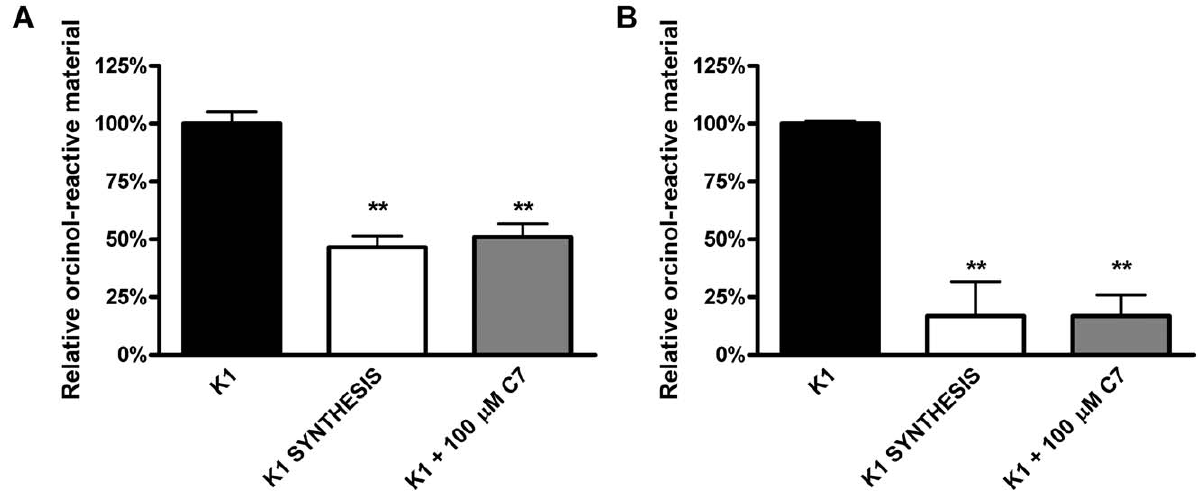
Figure 3. C7 treated cells produce less orcinol-reactive carbohydrates. Cells were ( A ) sonicated or ( B ) treated with mild acid to release cell surface polysaccharides. Material was then extracted and polysaccharides were detected using the orcinol reagent. C7 treated cells had levels of orcinol-reactive carbohydrates comparable to those of a capsule synthesis (K1 SYNTHESIS) mutant for both whole cell sonicates as well as released surface material. This suggests that capsule levels are reduced by C7 treatment, and the compound does not simply release capsule from the bacterial surface. Absorbance readings were expressed as the percent reactivity of the wild-type UTI89 K1 strain. K1 vs. SYNTHESIS mutant or C7 treated, p , 0.01; SYNTHESIS mutant vs. C7 treated p . 0.05 by Tukey’s t-test for both ( A ) and (B)